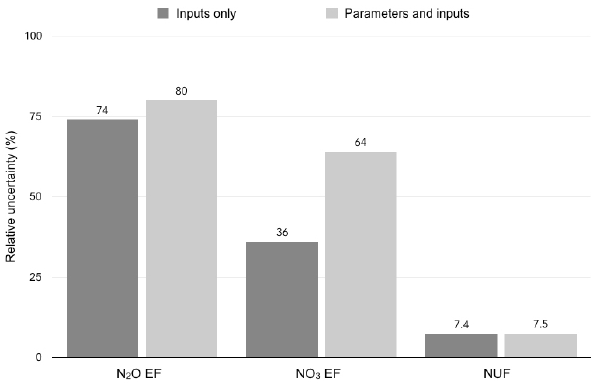
Figure 10. Uncertainty (expressed as relative uncertainty) of pre- dicted N 2 O EF, NO 3 LF and NUF as caused by the (1) variability in soil-related input data (inputs only) and (2) the variability in soil- related input data and model parameters (parameters and